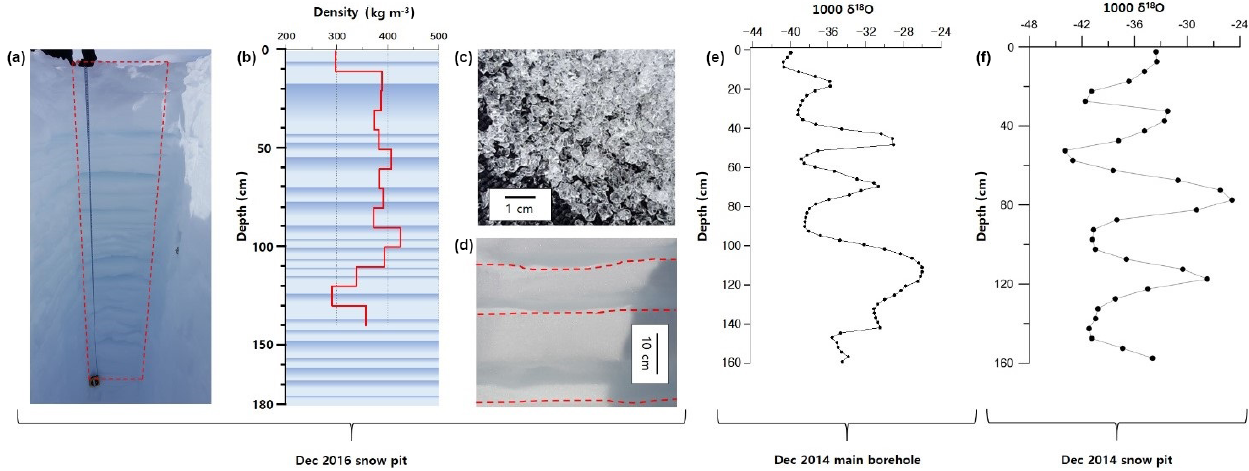
Figure 2. Snow pit photos at Styx Glacier. (a) The snow pit with dimensions of 280cm × 65cm × 220cm (length × width × height). (b) The illustration of qualitatively defined hard (dark blue) and soft (pale blue) layers observed in the top 180cm depth interval. Progressive blue color changes indicate a gradual density decrease with depth. The red line is a 10cm resolution density profile. (c) Coarse grains observed in a soft layer. The grains were placed on a black glove. (d) Enlarged snow layers. Dashed red lines indicate top boundaries of fine-grained hard layers. (e, f) Stable isotope ratio ( δ 18 O) of snow profiles at the main core and a snow pit 100m away from the main ice core borehole,